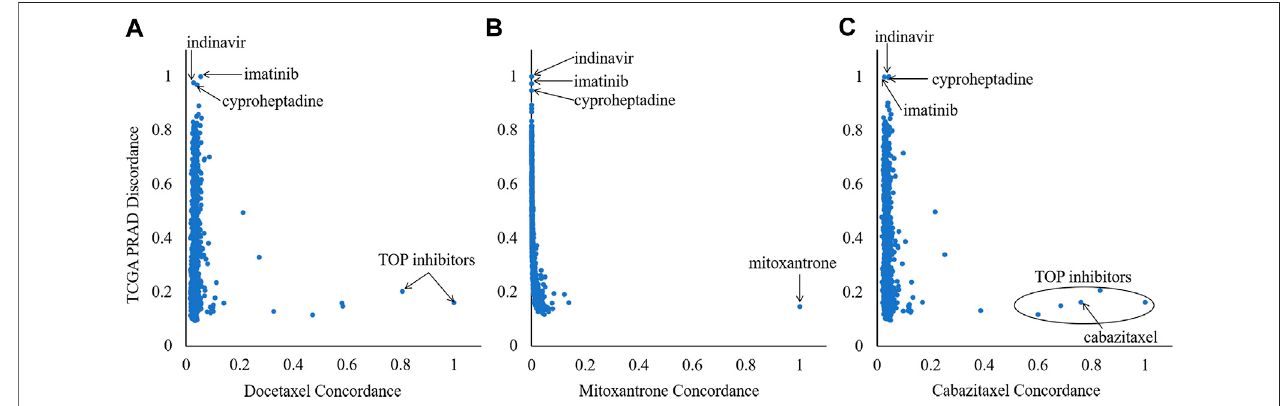
FIGURE 3 | Ranking of the 918 Library of Integrated Network-based Cellular Signatures compounds based on their orthogonality to the signatures of the three references (mitoxantrone, docetaxel and cabazitaxel). X -axis and Y -axis denote the CR and DR values, respectively.